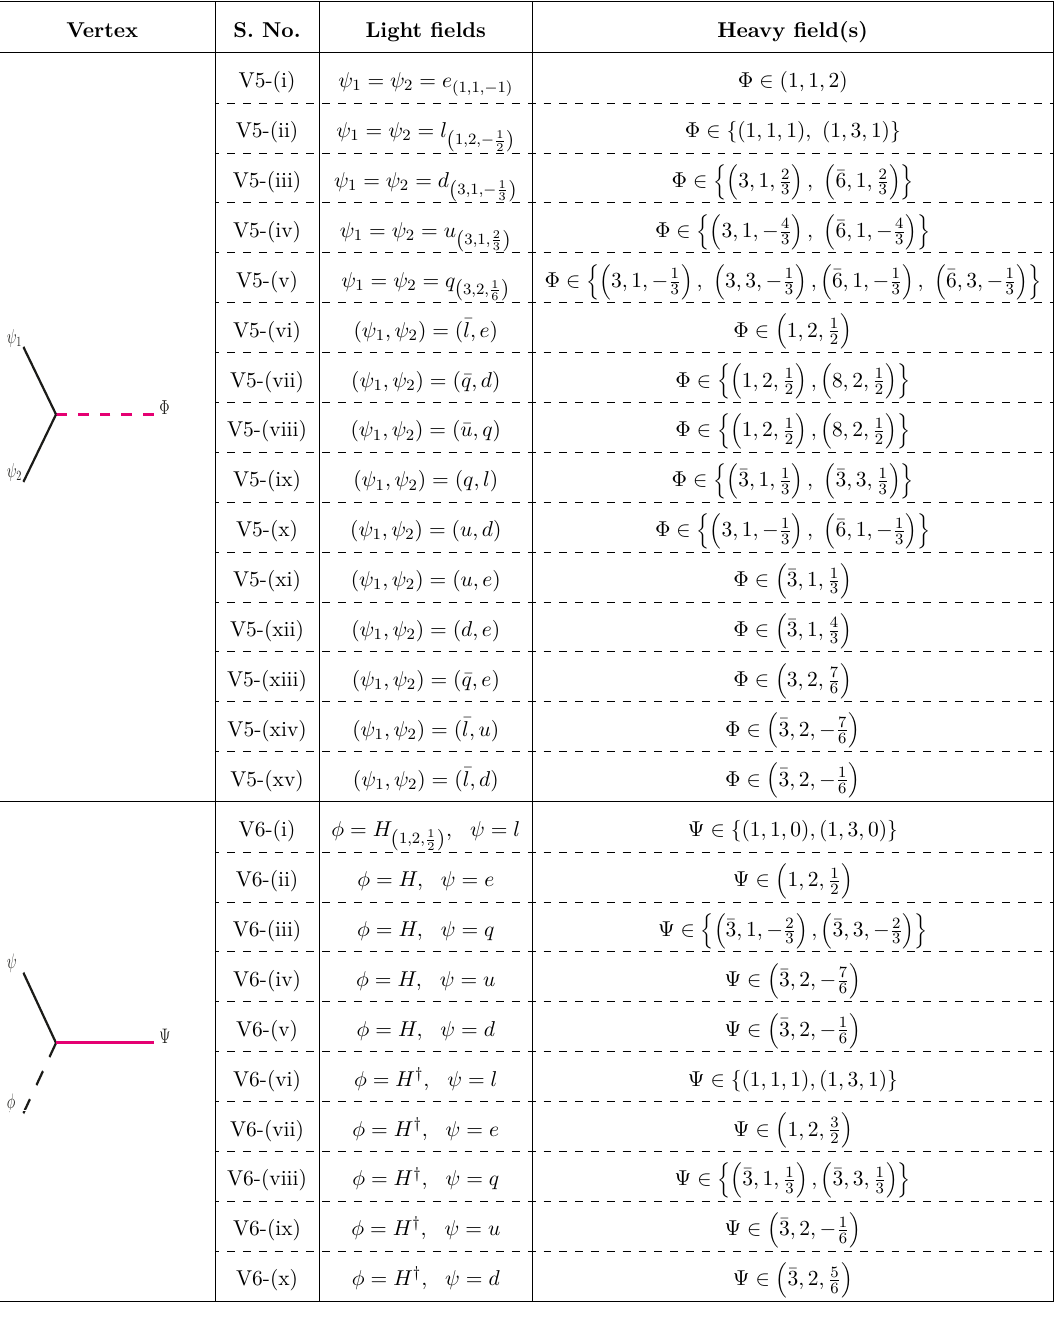
Table 3 . Table 2 continued. Here, φ i and ψ i denote the SM Higgs and the SM fermions respectively, whereas Φ and Ψ denote the various heavy scalars and heavy i i